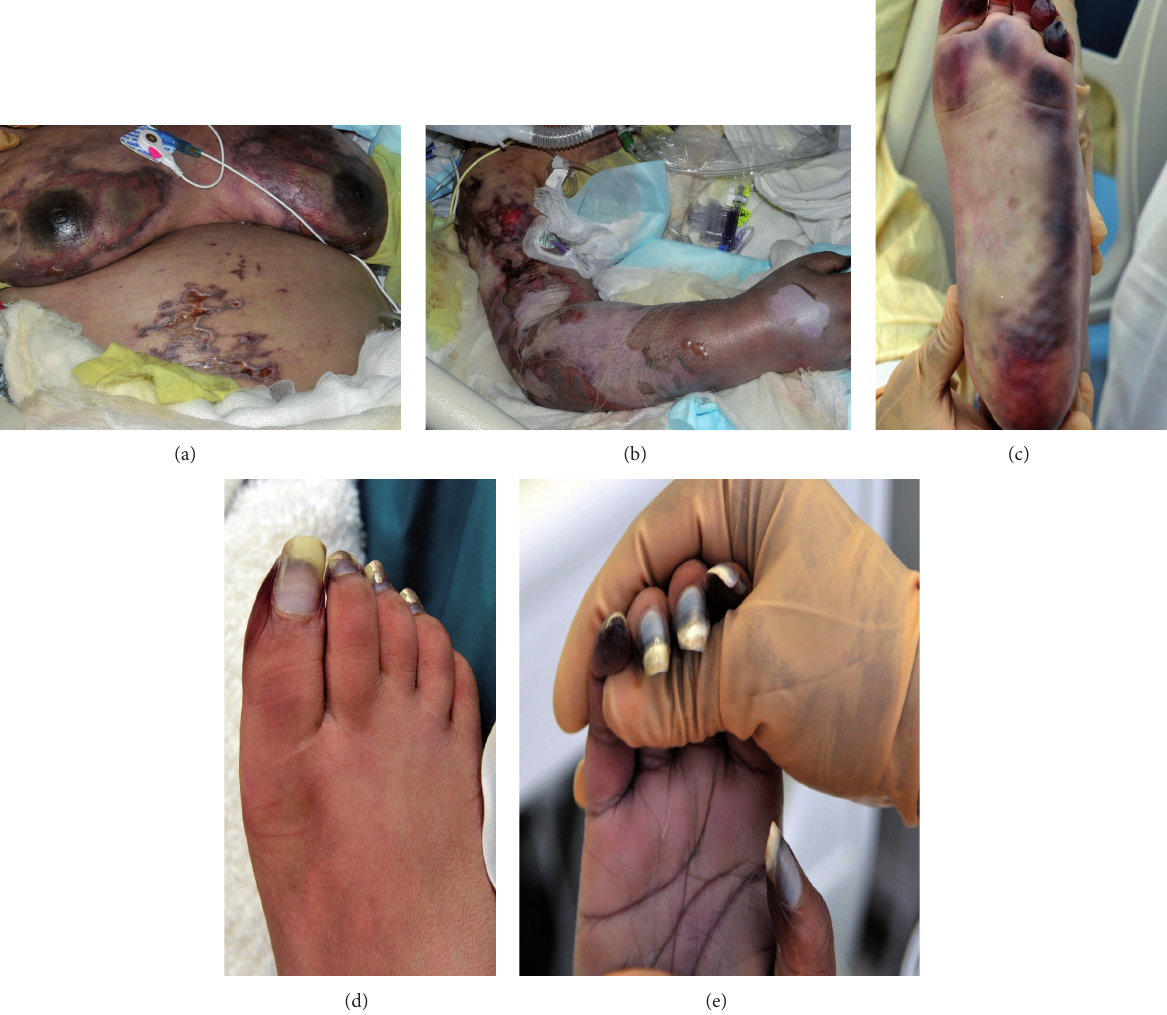
Figure 3: Dry gangrenous changes in the fingertips and